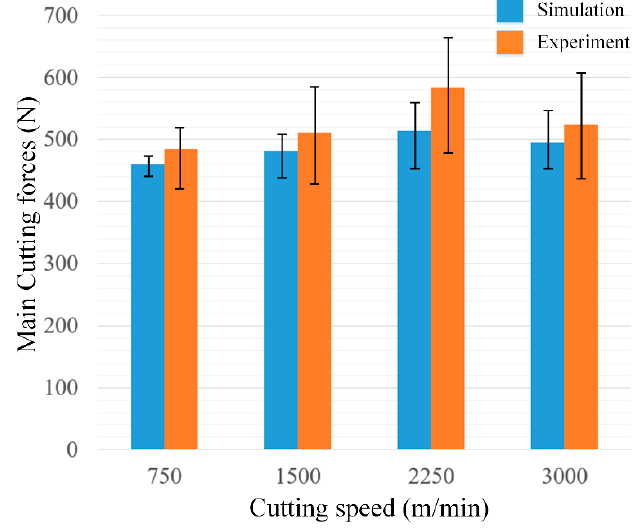
Figure 7. Simulation and experimental results of the main cutting forces.